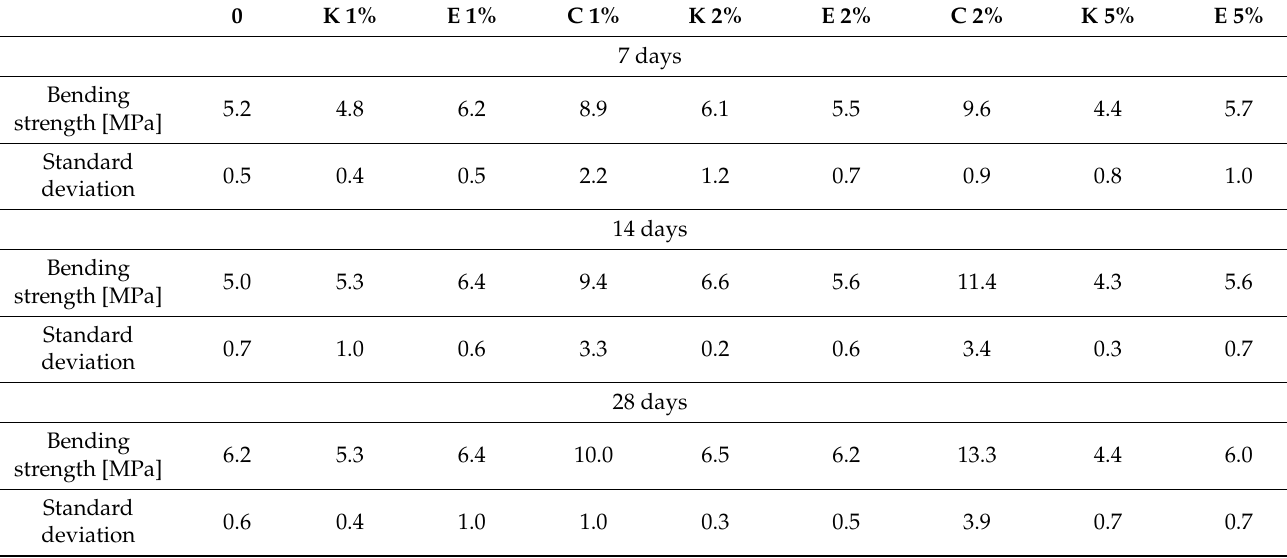
Table 7. Bending strength—tested geopolymer composites after 7, 14, and 28